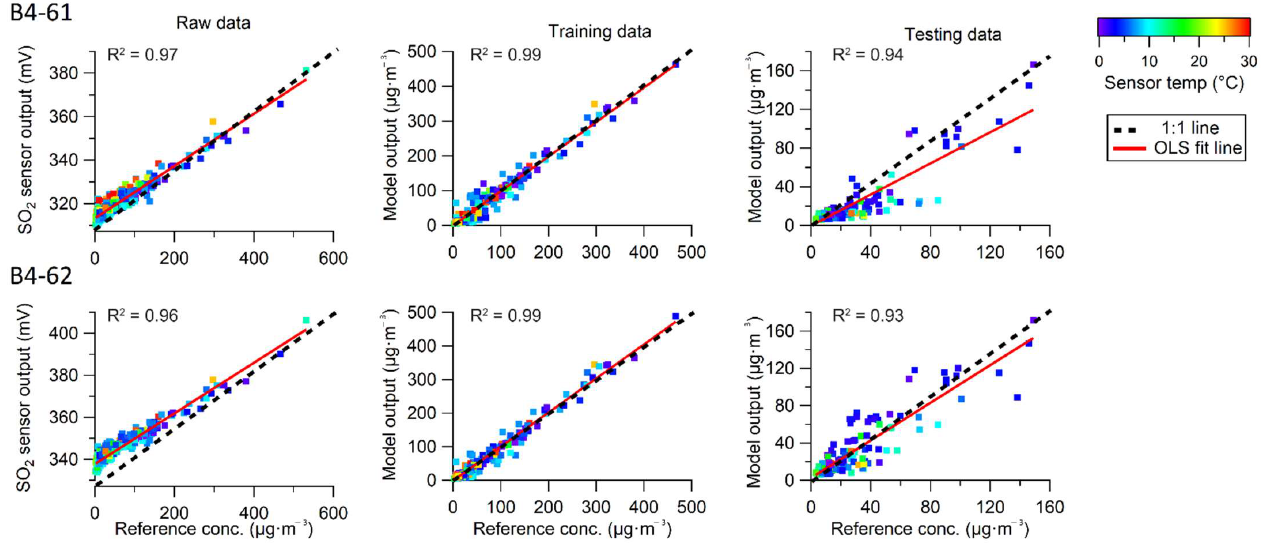
Figure 7. Scatterplots of SO 2 (1-h average) measured in the training campaign by the reference in- strument and the sensors (raw and calibrated response). instrument and the sensors (raw and calibrated